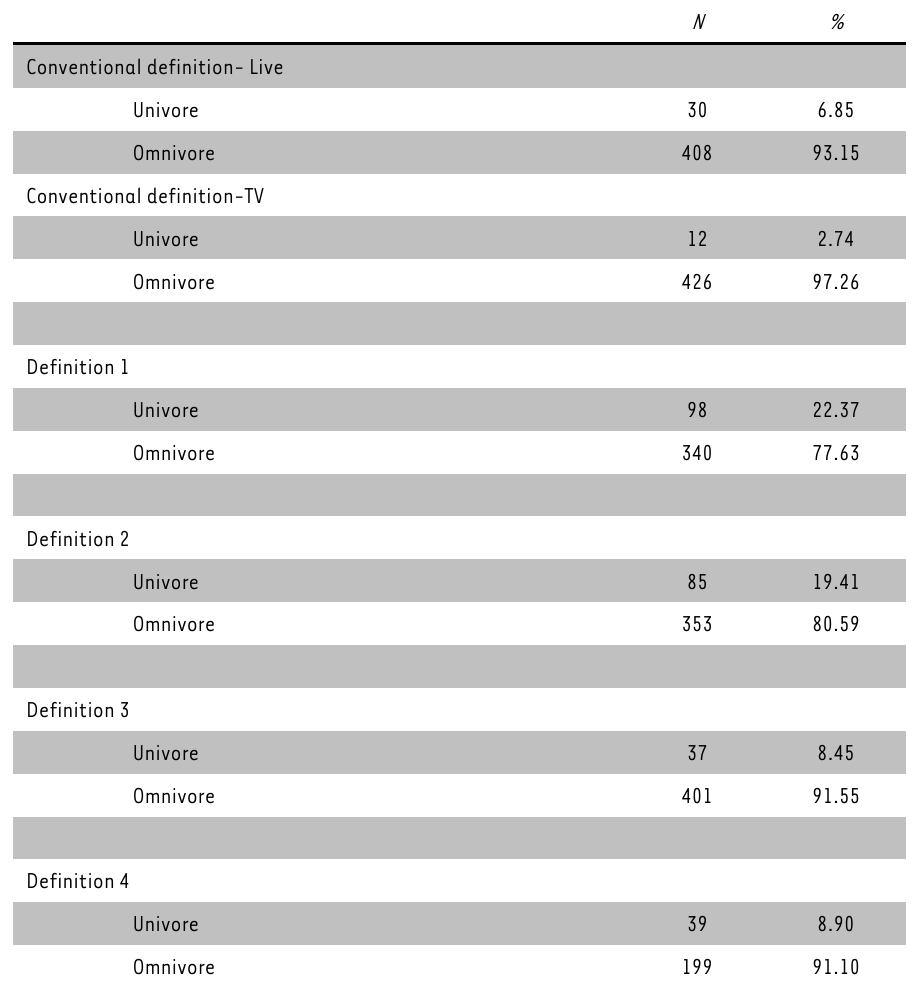
TABLE 2: Omnivore/univore